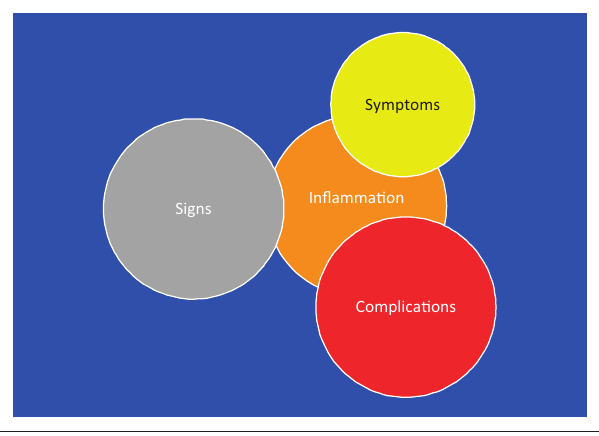
FIGURE 2: Inflammation determines clinical problems in the nose.